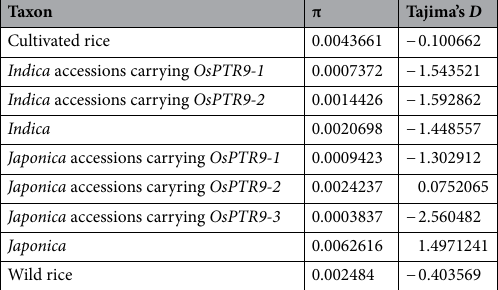
Table 3. Nucleotide diversity and Tajima’s D Test of